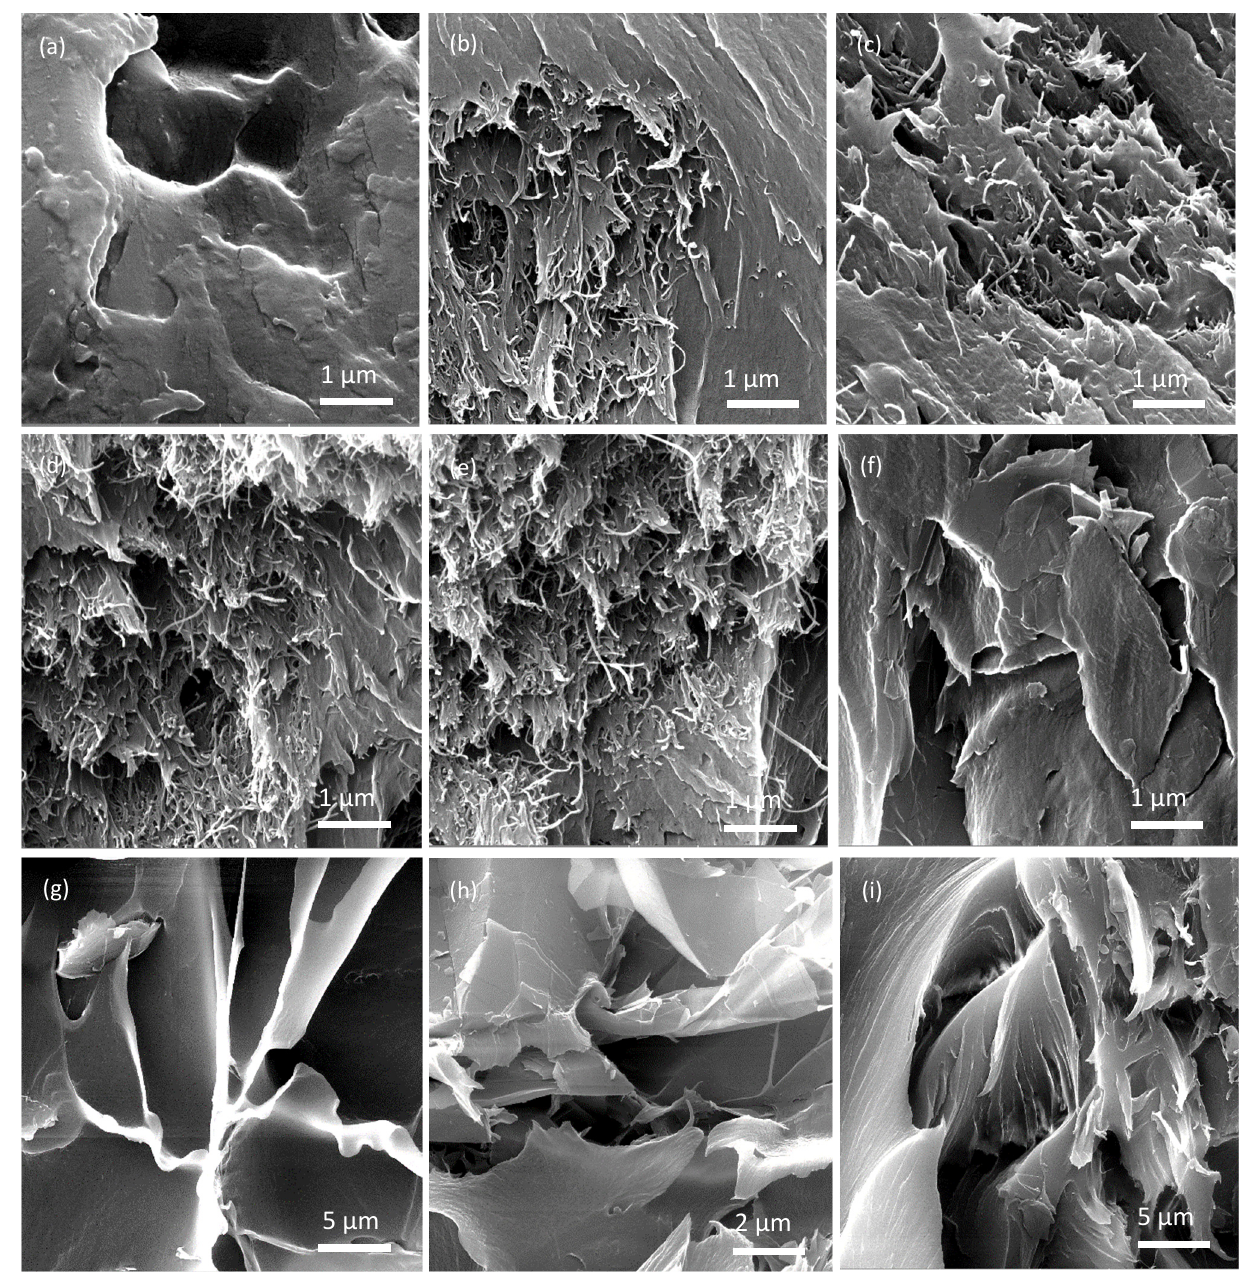
Figure 4. FESEM micrographs of compositions: ( a ) pure PSU, ( b ) PSU-1wt%CNT, ( c ) PSU-3wt%CNT ( d ) PSU-5wt%CNT, (e ) PSU-10wt%CNT, ( f ) PSU-1wt%GNP, ( g ) PSU-3wt%GNP, ( h ) PSU-5wt%GNP, and ( i ) PSU-10wt%GNP.